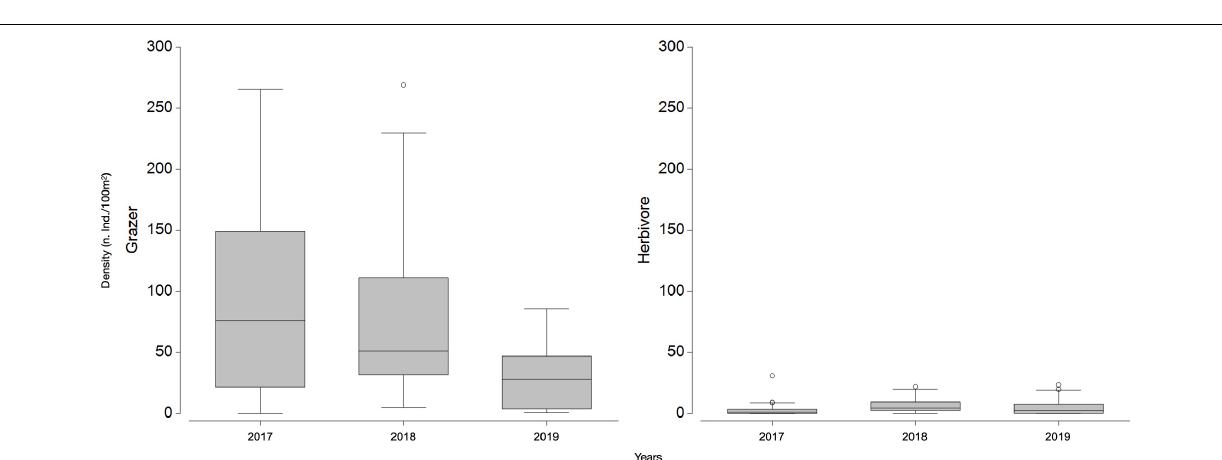
any functional groups (SFG = b) and a macroalgae